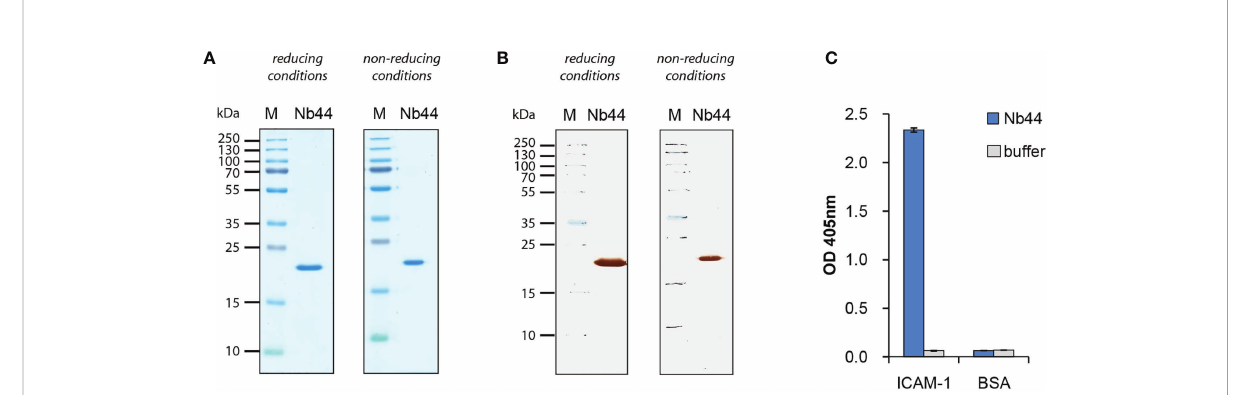
FIGURE 2 Expression and puri fi cation of nanobodies. (A) Coomassie Brilliant Blue-stained SDS-PAGE of ICAM-1-speci fi c nanobody (Nb44) under reducing and non-reducing conditions and (B) nitrocellulose-blotted Nb44 under reducing and non-reducing conditions, detected with HRP-coupled mouse anti-HA antibody. Lane 1: protein molecular mass marker protein molecular mass marker (M), lane 2: puri fi ed Nb44, 1µg. Molecular masses are indicated on the left margin in kDa. (C) Reactivity of Nb44 to plate-bound ICAM-1 and control protein BSA. OD values (y-axis) correspond to the amount of bound nanobodies and are shown as means of triplicates ± SD. Data shown are representatives of 4 independent